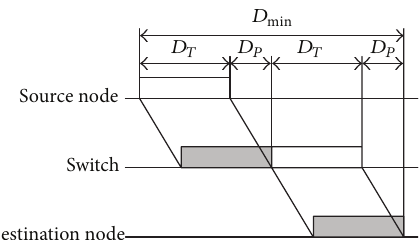
Figure 4: The timing diagram of a single-level switched